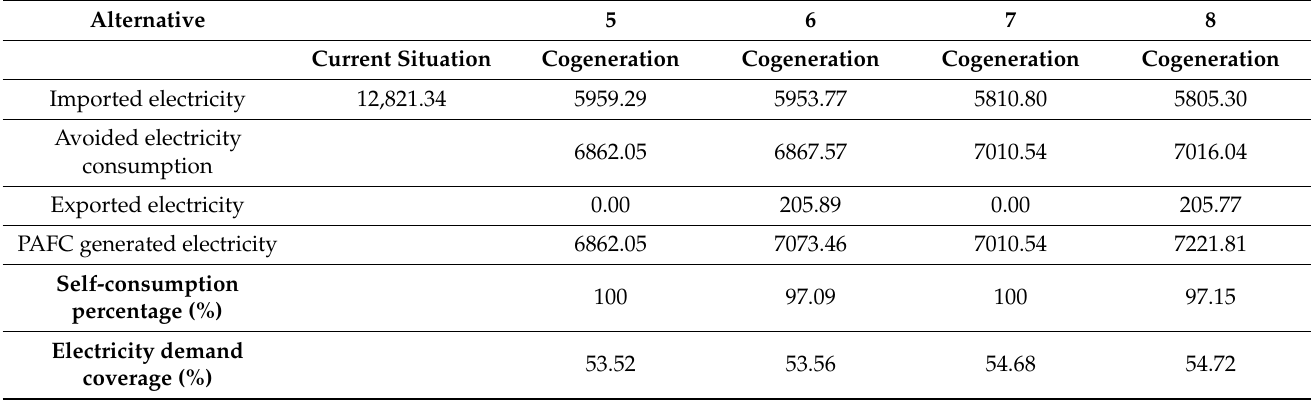
Table A5. Electrical Energy Balance (MWh/year) for alternatives considering 1 MW fuel cell